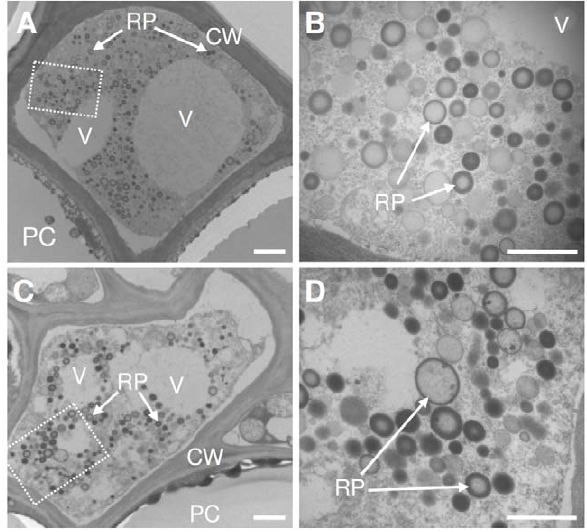
Figure 3. In situ analysis of the ultra-structure of rubber particles from TbSRPP-RNAi transgenic plants and wild-type plants by transmission electron microscopy. A. Micrograph of ultra-thin cross sections of roots from TbSRPP-RNAi transgenic plant (S3) at low and B. higher magnification. C. Micrograph of ultra-thin cross sections of roots from a wild-type plant at low and D. higher magnification. Enlarged areas are indicated with dashed boxes. Key: RP, rubber particle; V, vacuole; CW, cell wall; PC, parenchyma cell. Scale bars =1 m m. doi:10.1371/journal.pone.0041874.g003 PLoS ONE |